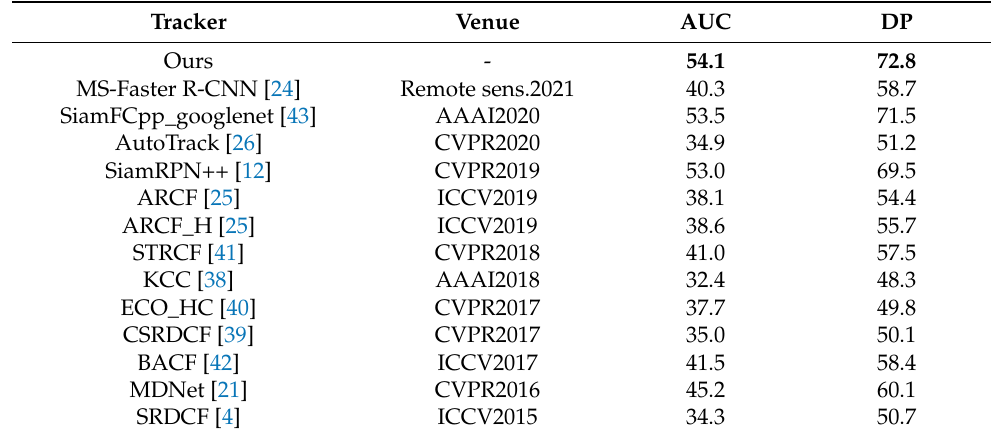
Table 4. Comparison results of the AUC score and DP score by using the proposed method and eleven state-of-the-art trackers on the UAV20L dataset. Tracker